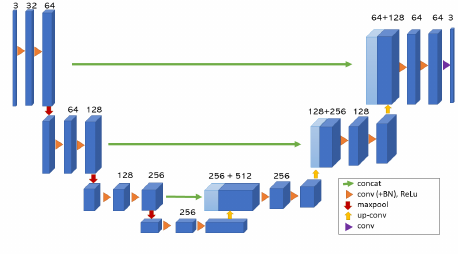
Figure 6: 3D U-Net